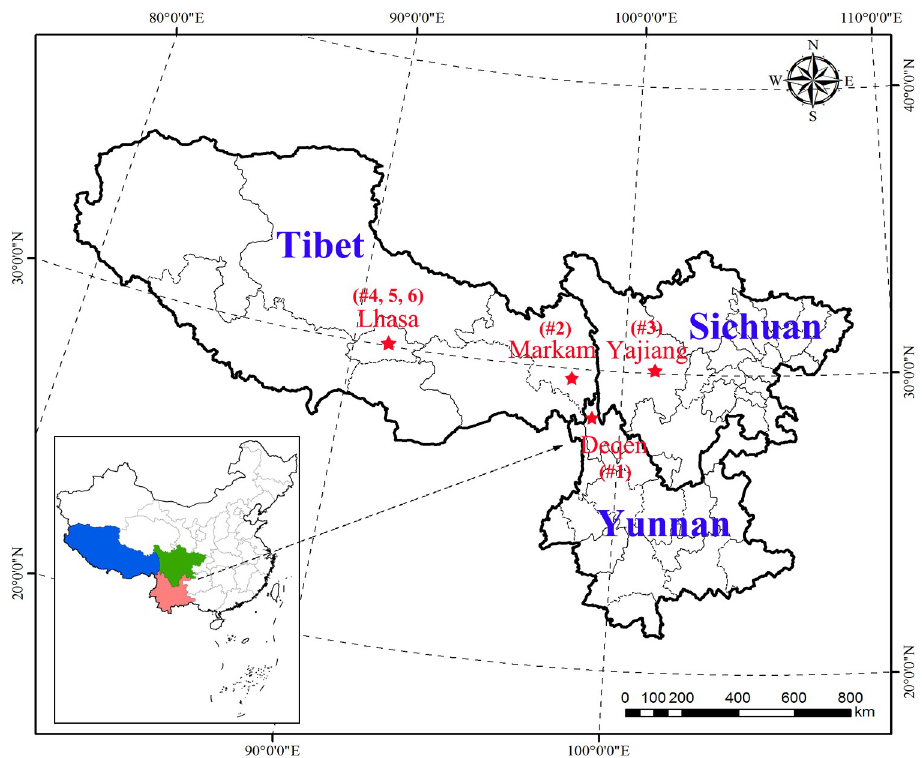
Fig 7. A map of Southwest China showing the collection points for P . szechuanica var. tibetica specimens. Solid stars represent the sample collection positions. A total of five positions belonging to three geographical regions were used in this study. Numbers inside parentheses represent the code for the specimens collected at this